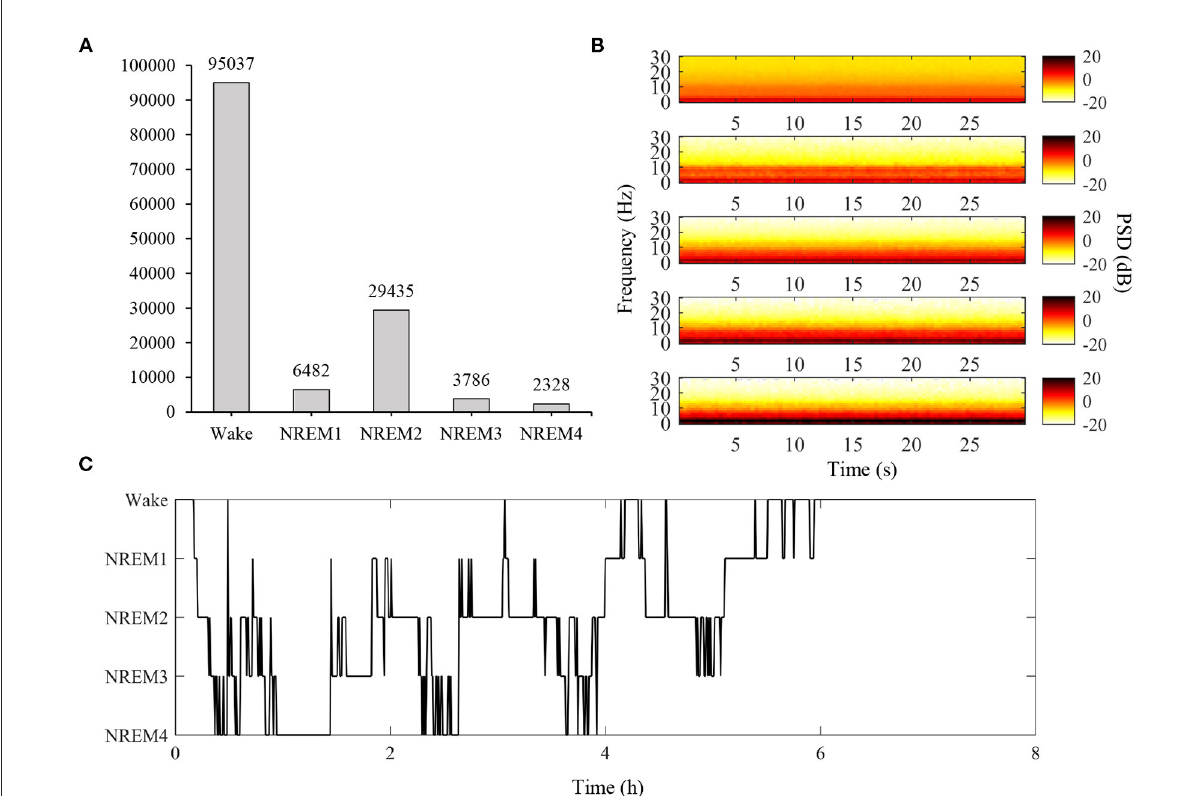
FIGURE4 Overview of training data from modified Sleep-EDF dataset. In Data Set-B, an open dataset was modified to provide large sleep stage data, unlike other competition tracks. (A) Total number of samples according to classes in the training set. For this competition, we selected a total of 50 EEG data from 20 males and 30 females, excluding missing data and subjects outside the range of 25–56 years of age. (B) Spectrogram of DataSample01 based on classes. From top to bottom, the figure represents the average spectrogram for Wake, NREM1, NREM2, NREM3, and NREM4 states (PSD: power spectral density). (C) Hypnogram of DataSample01. (PSD, power spectral